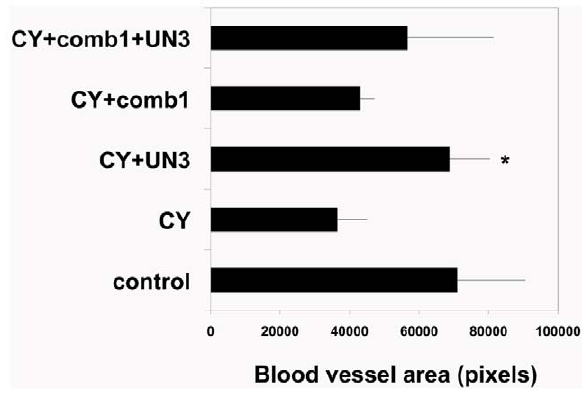
Figure 9. Quantitative evaluation of wound healing angiogen- esis induced by the peptides. Immunohistochemistry for CD31 and HSPG was used to identify blood vessels in 10 days old wounds. The areas occupied by the blood vessels were identified by colocalized CD31 and HSPG staining and quantified using ImageJ. At least two wounds were quantified for each condition. Data are presented as mean + / 2 standard error; * - indicates p , 0.05 compared to CY alone.